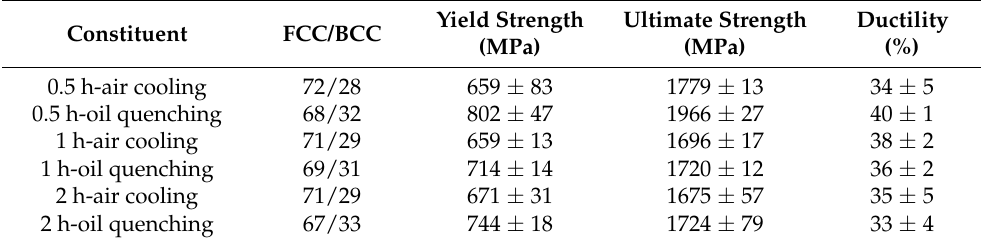
Figure 12. Mechanical compressive stress–strain curves of the Al 50 Ti 20 Cr 10 Mn 15 V 5 MEAs annealed at 1000 °C for 0.5, 1, and 2 h, followed by air-cooling and oil-quenching. Table 4. Mechanical compressive properties of the Al 50 Ti 20 Cr 10 Mn 15 V 5 MEAs annealed at 1000 ◦ C for 0.5, 1, and 2 h, followed by air-cooling and